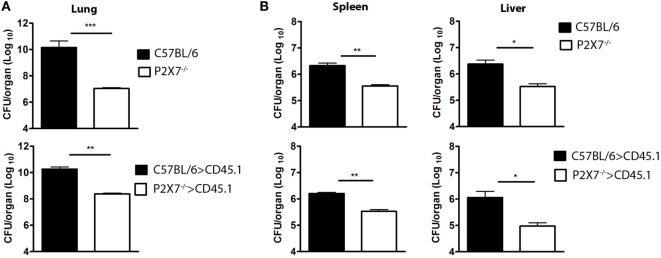
Bacterial loads in the lungs, spleen, and liver of chimeric and non-chimeric mice on day 28 p.i. C57BL/6, P2X7−/−, C57BL/6>CD45.1, and P2X7−/−>CD45.1 mice were infected with MP287/03 bacilli. Numbers of colony-forming units (CFUs) in the lungs (A), spleen, and liver (B) are shown. Significant differences were observed for the indicated groups (*p < 0.05, **p < 0.01, and ***p < 0.001). The data are representative of three separate experiments with three to five mice each (means ± SEM).